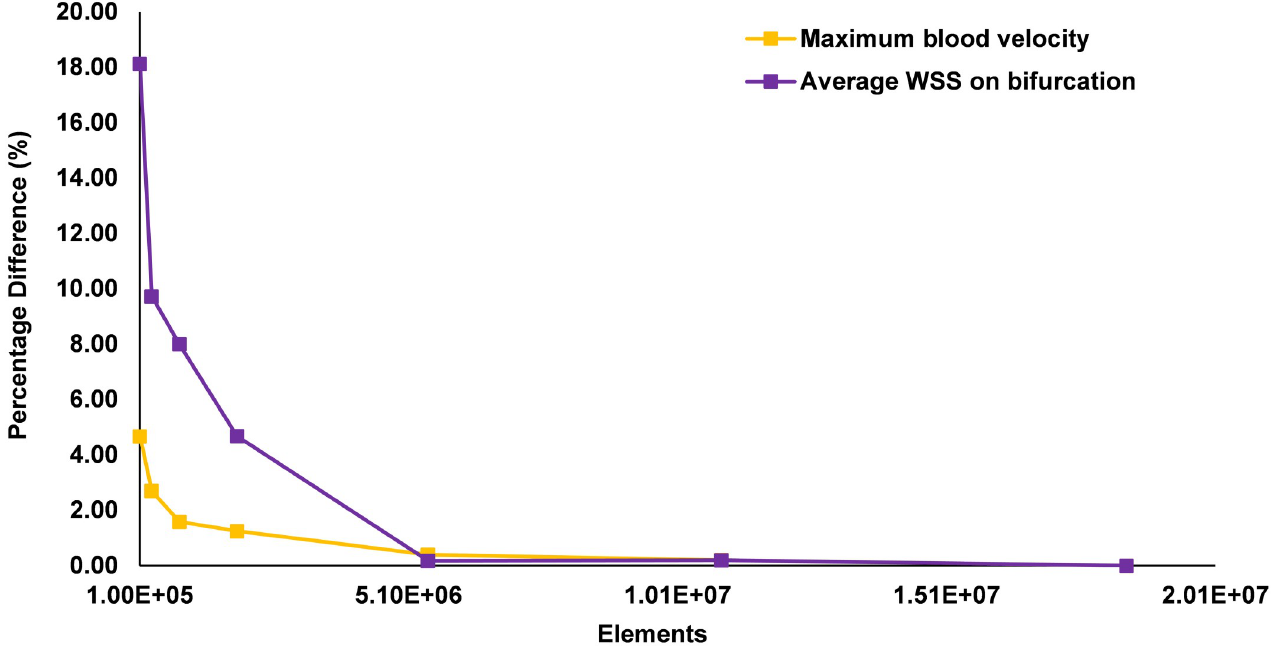
Fig 5. Percentage difference in peak velocity and bifurcation average wall shear stress for 7 mesh refinements.